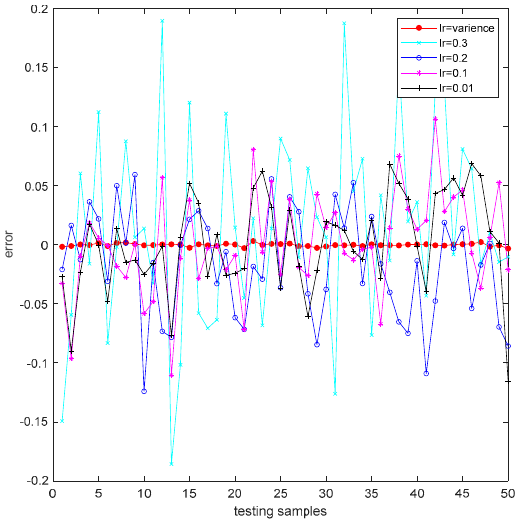
Figure 9. Training error for different learning rates.